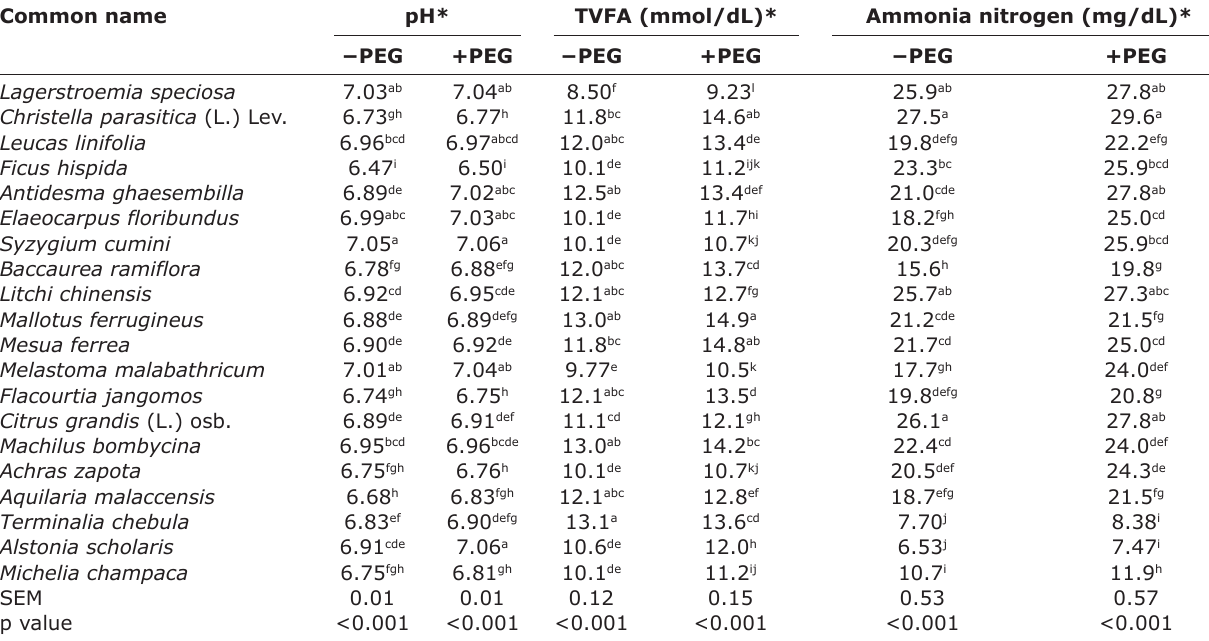
Table-3: Effect of medicinal plant leaves and PEG addition on rumen fermentation